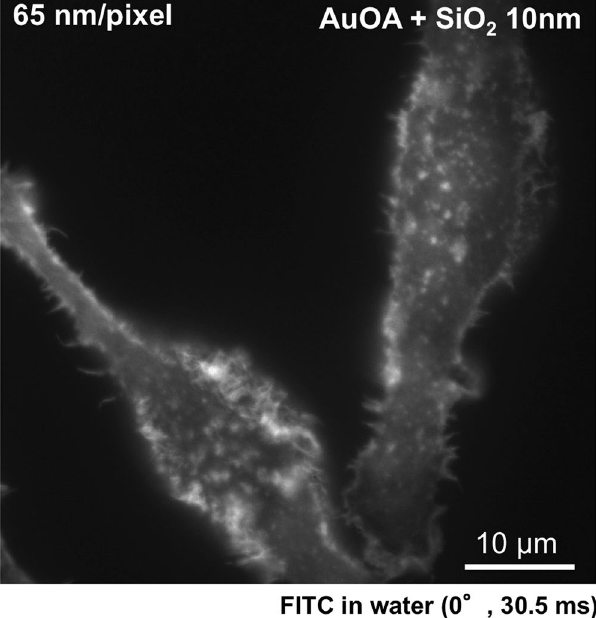
Figure 5. High spatiotemporal resolution image of the FITC-labeled actin filaments in RBL-2H3 on the SiO 2 - AuOA sheet. The image was taken under an epifluorescence microscope (incident angle: 0°) in aqueous medium with a super-resolution digital CMOS camera (65 nm/pixel). The cells were attached on the AuOA sheet with a 10 nm thick SiO 2 layer. The images were taken with a laser 561 nm in wavelength (5 mW), and the exposure time was 30.5 msec. The incubation time for the cell adhesion was the same as that in Fig. 3 (overnight). The image taken by a regular TIRF camera (160 nm/pixel) is available in Supplementary Fig. S9 for comparison. The magnified images are available in Supplementary Fig.